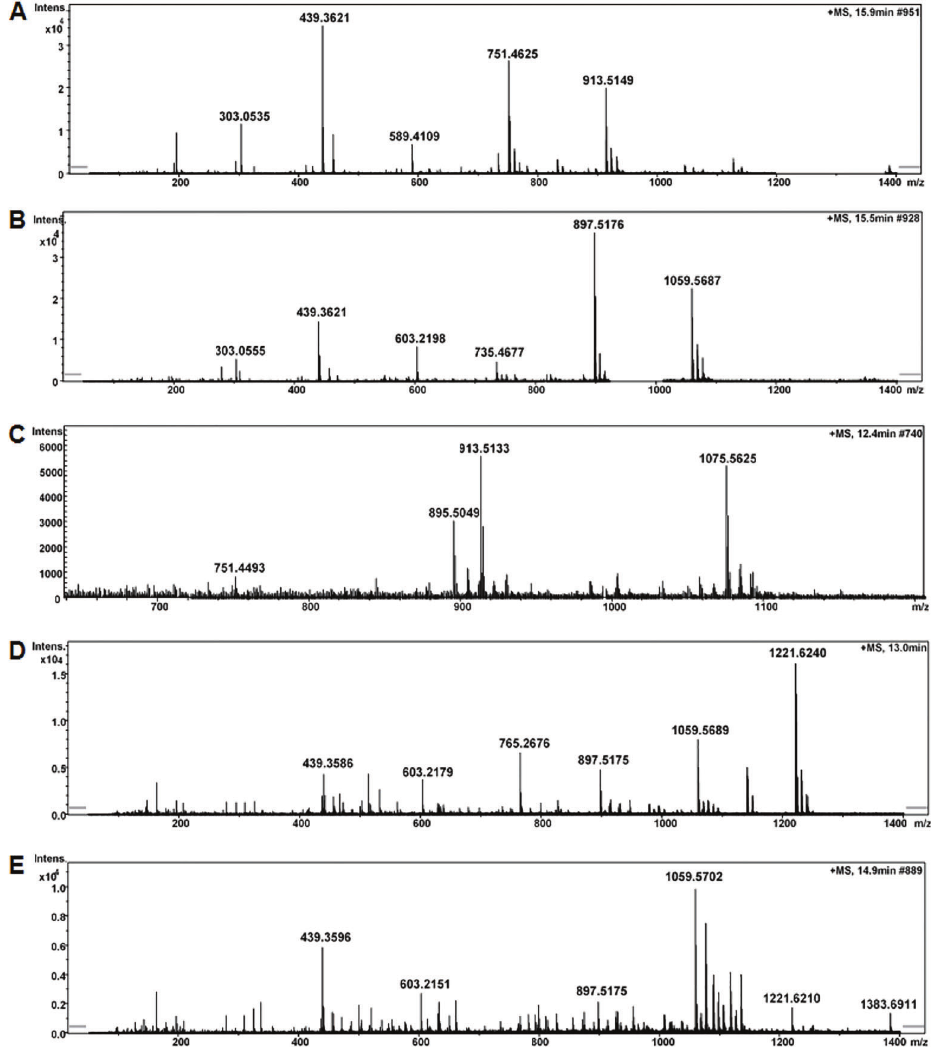
Figure 2. Spectra of ion fragments obtained from analysis of yerba mate ( Ilex paraguariensis ) extracts. Analysis performed by using electrospray ionization in positive ion mode. Ion fragments correspond to chemical compounds presented in Table 1. A , Matesaponin 1 ([M + H] + =913); B , Matesaponin 2 ([M + H] + =1059); C , Matesaponin 3 ([M + H] + =1075); D , Matesaponin 4 ([M + H] + =1221); E , Matesaponin 5 ([M + H] +